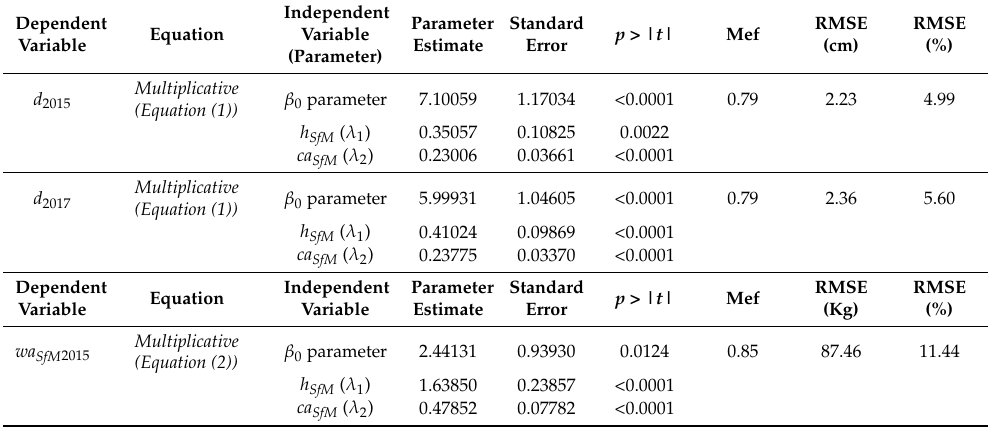
Table 4. Models selected for estimating SfM-derived individual tree diameter and SfM-derived individual tree aboveground